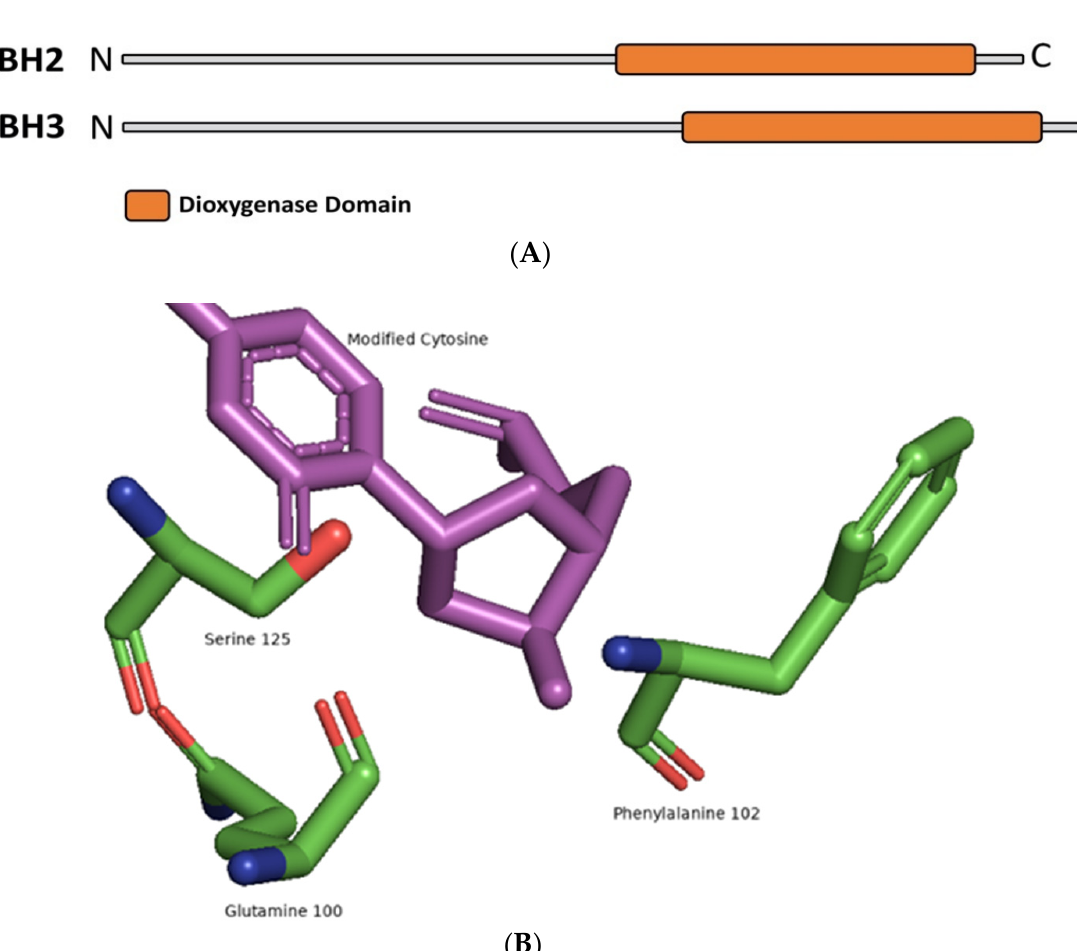
Figure 3. ( A ) Domain architecture of Human ALKBH2, ALKBH3. ( B ) Amino acid residues reside in close proximity to, and interact with, the flipped out modified cytosine base in ALKBH2 (PDB ID- 3BTZ).